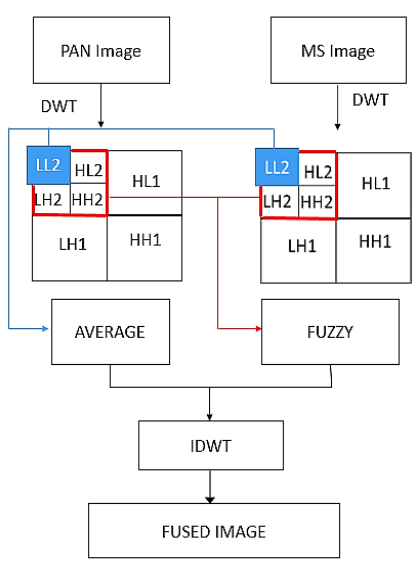
Figure 3. Diagram of proposed Fuzzy-DWT fusion algorithm